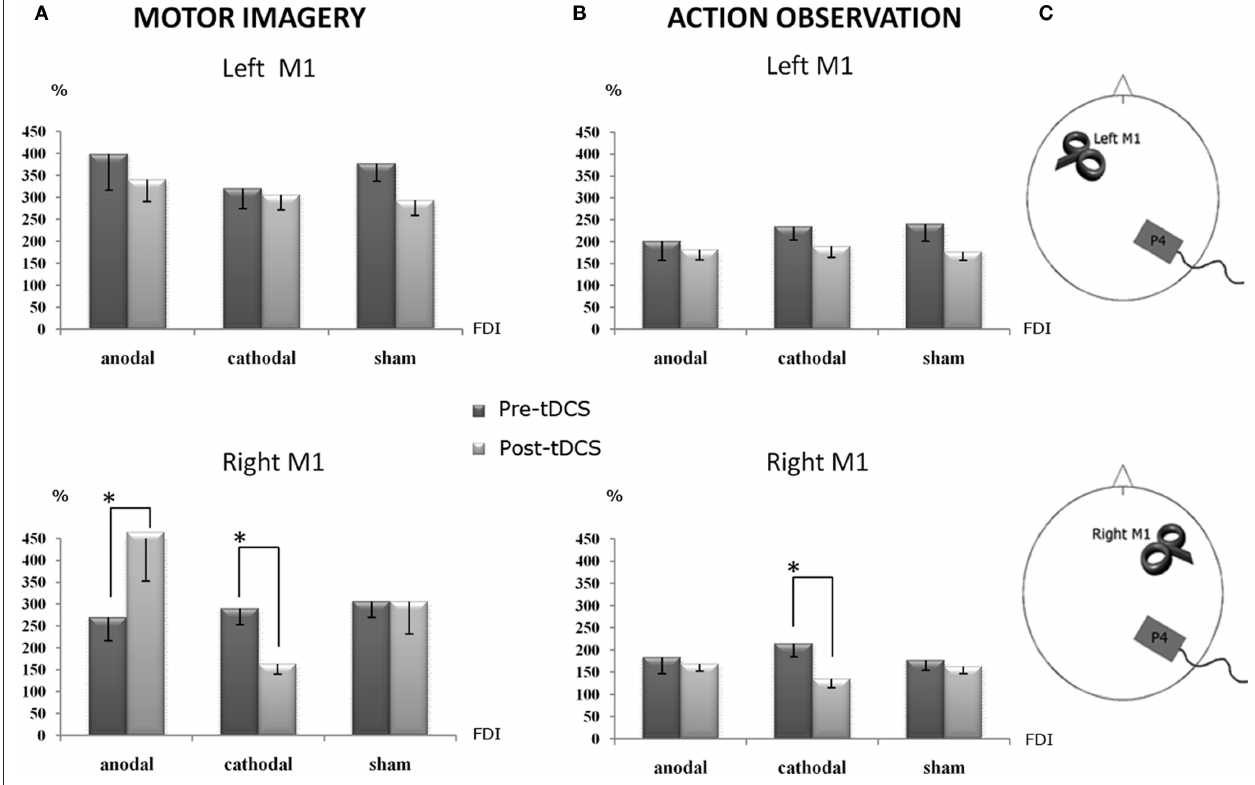
Figure 2 | Percentage changes of mean MePs’ amplitude values during the different experimental conditions. A value of 100% indicates, independently for each subject, the mean value during the baseline condition prior tDCS. The error bars correspond to 1 SE. An asterisk (*) indicates significant differences between the experimental conditions. tDCS was always delivered over the right parietal cortex. (A) The corticospinal facilitation induced by motor imagery, as indexed by the MEPs’ size. During the anodal session, after tDCS application, the MEPs’ size (post-tDCS) significantly increased with respect to